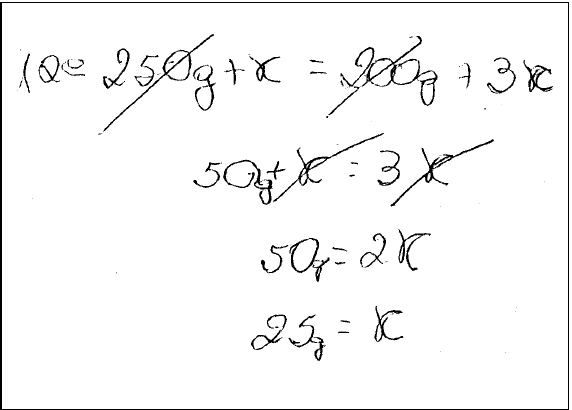
Figura 8 . Protocolo de um sujeito na resolução de